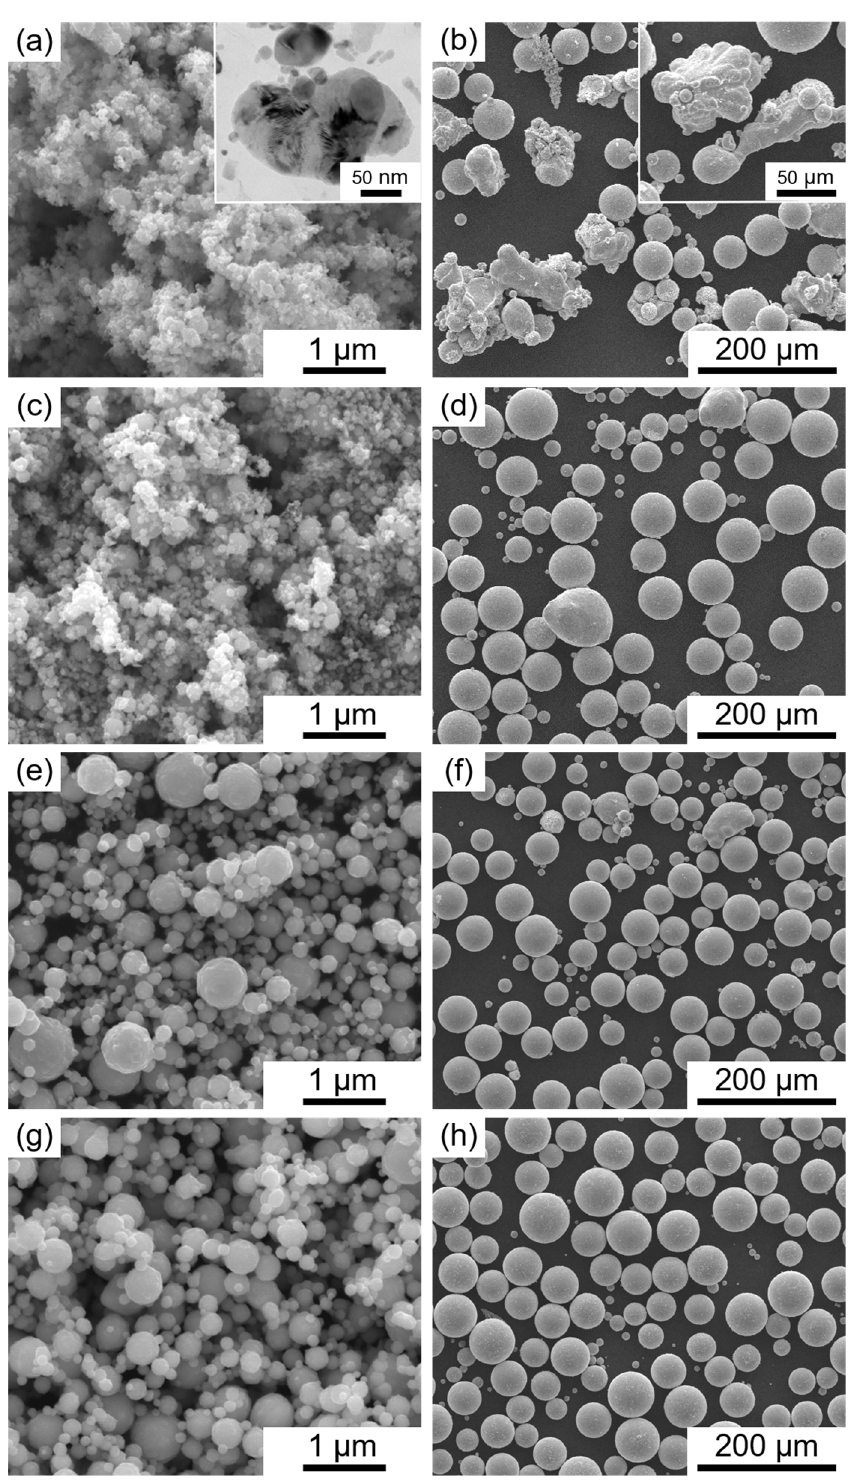
Figure 6. SEM images of the NP-powder and CS-powder at different reaction pressures: ( a ) and ( b ) 6 Psia, ( c ) and ( d ) 9 Psia, ( e ) and ( f ) 12 Psia, ( g ) and ( h ) 15 Psia.